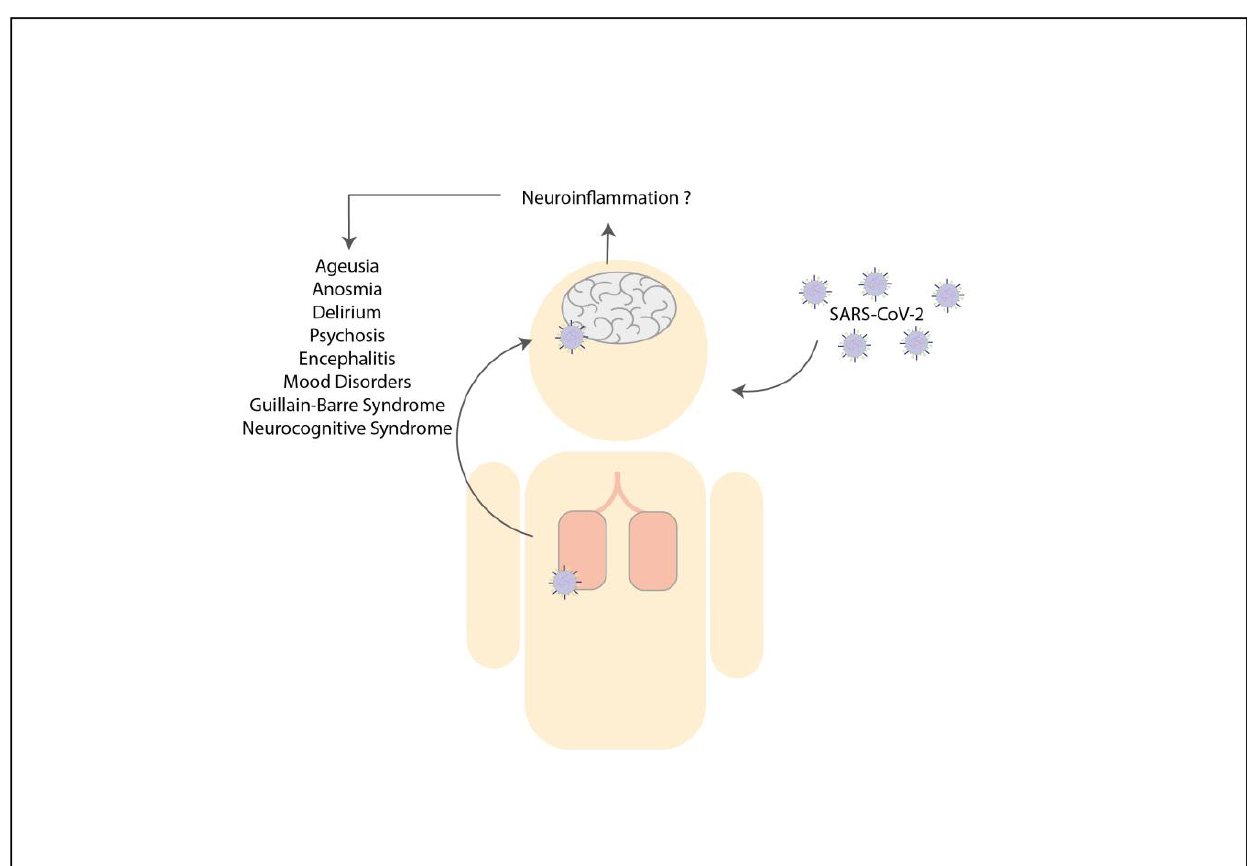
Figure 3. Infection with SARS-CoV-2 could cause neurologic consequences in patients. The respiratory infection with SARS-CoV-2 might lead to neuroinflammation as a consequence of a cytokine storm, which might increase the pro-inflammatory cytokines in the brain [74]. This increase might promote the development of neurologic disorders such as ageusia, anosmia, delirium, psychosis, encephalitis, mood disorders, Guillain-Barré Syndrome, and neurocognitive syndrome [75,76,159,164,165].